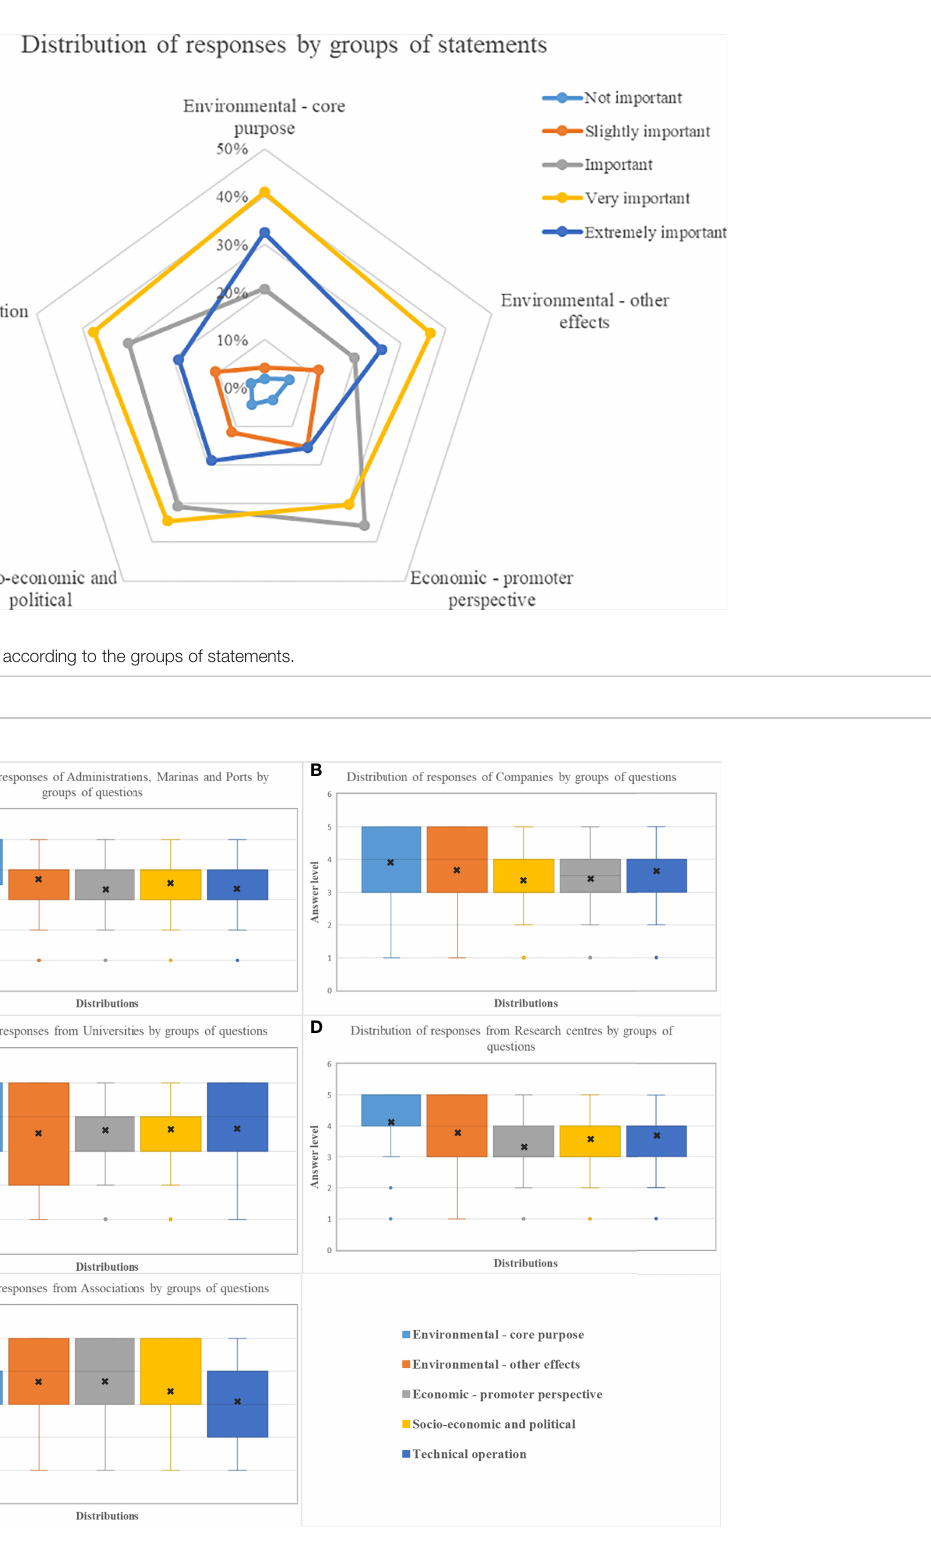
FIGURE 7 | Distribution of the responses according to the institution of the respondents [ (A) Administrations, Marinas and Ports; (B) Companies; (C) Universities; (D) Research Centers; (E) Associations] by groups of statements (represented by coloured